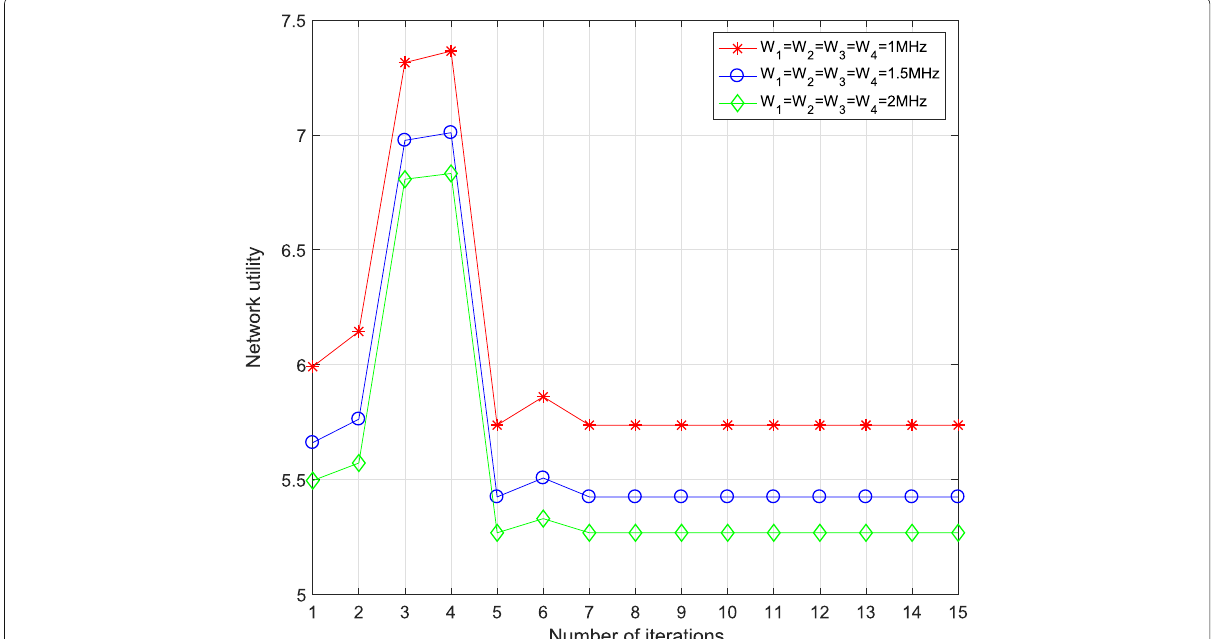
Fig. 3 Network utility versus the number of iterations. The network utility of the system versus the number of iterations obtained from the proposed